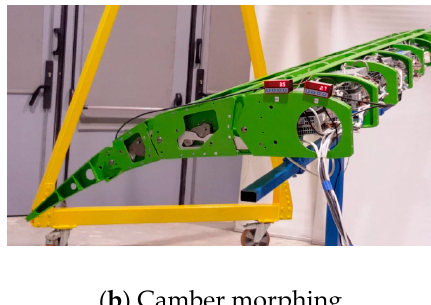
Table 4. Functionality test protocol